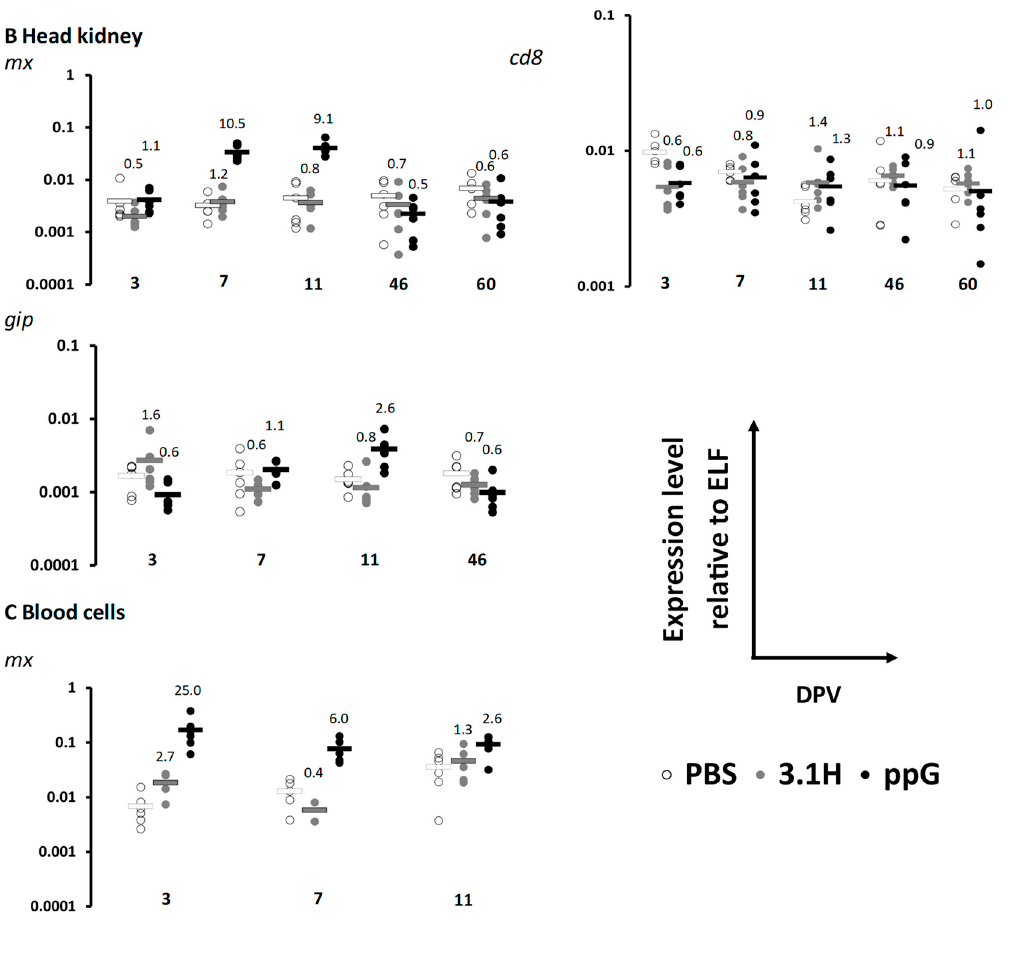
Figure 2. Kinetics of gene expression from the lethal experiment (Exp 1) in animals injected (i.m.) with PBS, vector only (3.1H), or the DNA vaccine (ppG) in the muscle tissue at the site of injection ( A ), in the head kidney ( B ), or in the blood cells ( C ), for mx , gip , cd8, or cd83 . Individual data are represented as well as the average (horizontal line) (n = 6), the time point is indicated as day post-vaccination (dpv), and the fold change in gene expression in ppG and 3.1H groups relative to the PBS group is